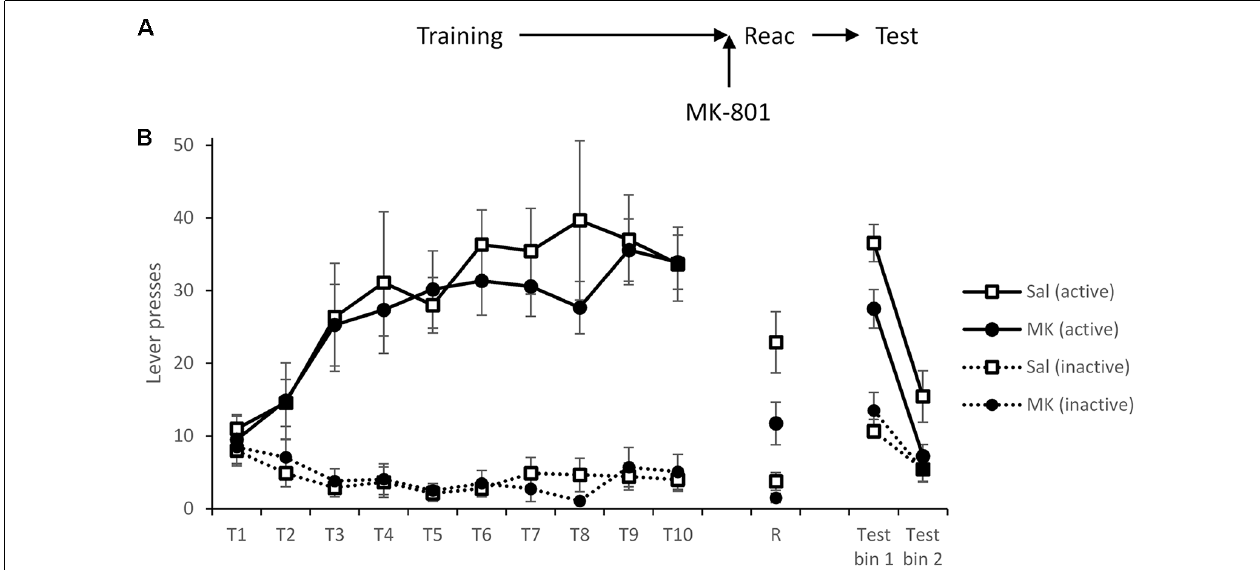
FIGURE 1 | Long-term lever pressing was significantly impaired at test following administration MK-801 in conjunction with a reactivation session. (A) Schematic of the experiment. (B) Rats learned to self-administer cocaine over training days 1–10 (T1–T10). At reactivation (R), overall responding was acutely reduced by MK-801 ( n = 12) administration compared to saline-injected controls ( n = 9), however, this was not specific to either lever. In a 90-min extinction test, previously MK-801 treated rats made significantly fewer responses on the active (previously cocaine paired) lever. Data are presented as summary mean ± SEM.